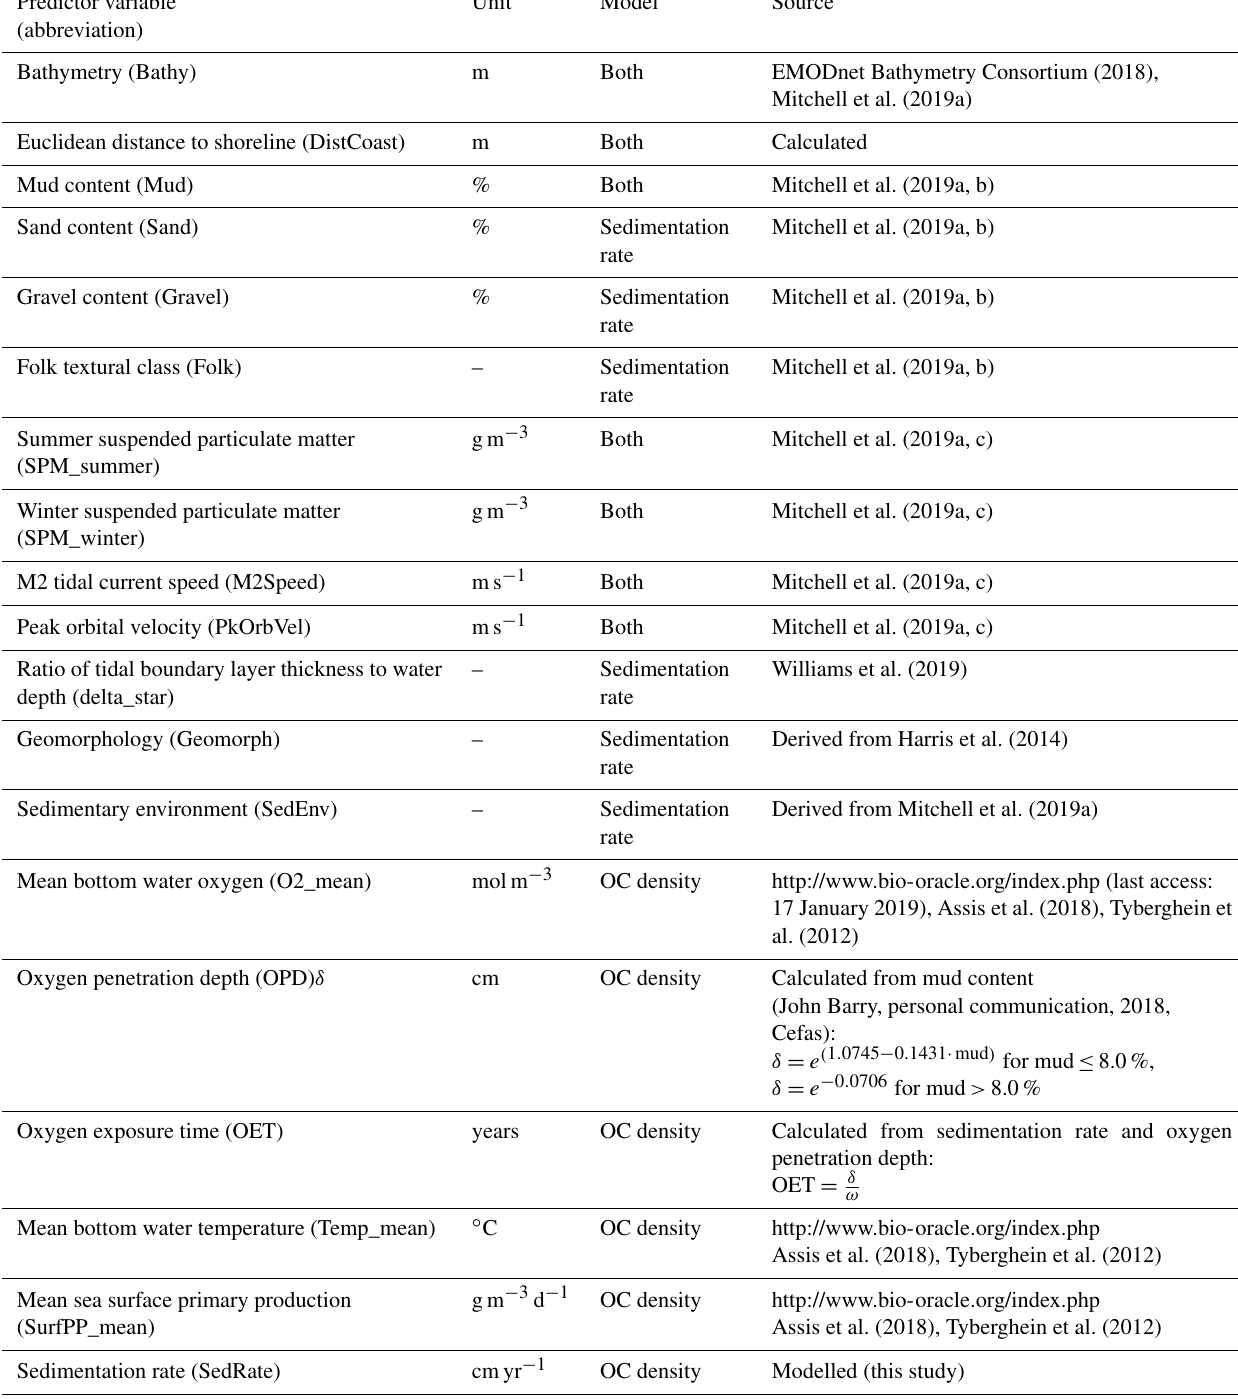
Table 1. Predictor variables used in the sedimentation rate and OC density